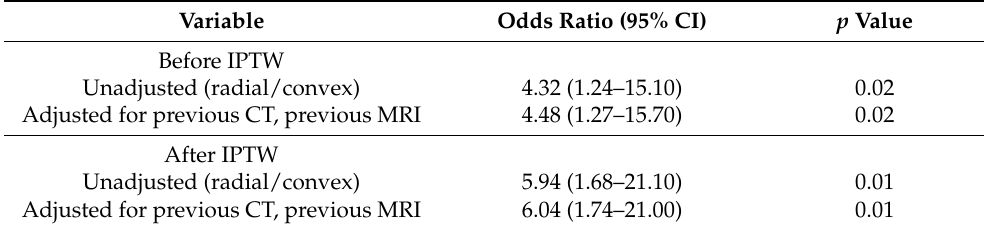
Table 4. Univariate and multivariate conditional logistic regression analysis of indirect findings after